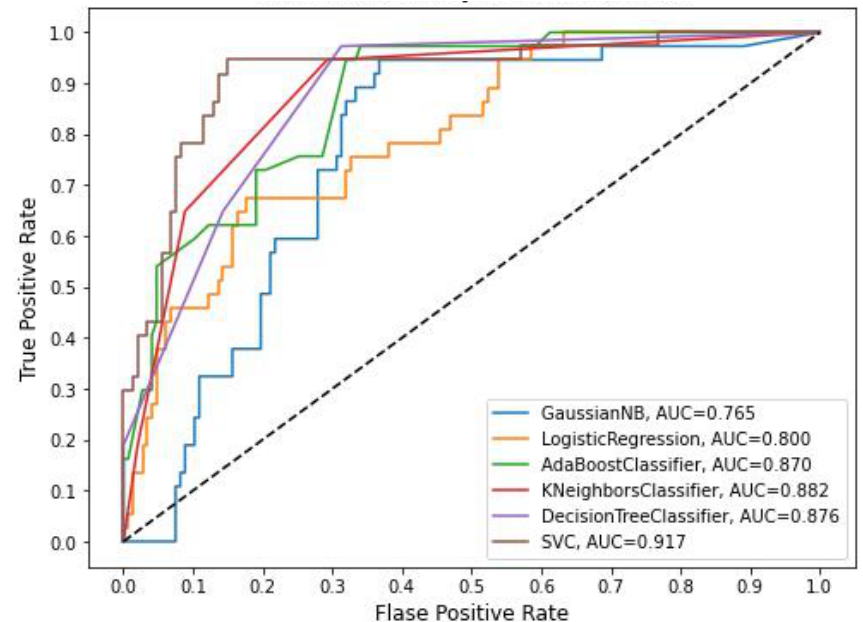
Figure 5. ROC curve of ML models based on the χ 2 feature selection